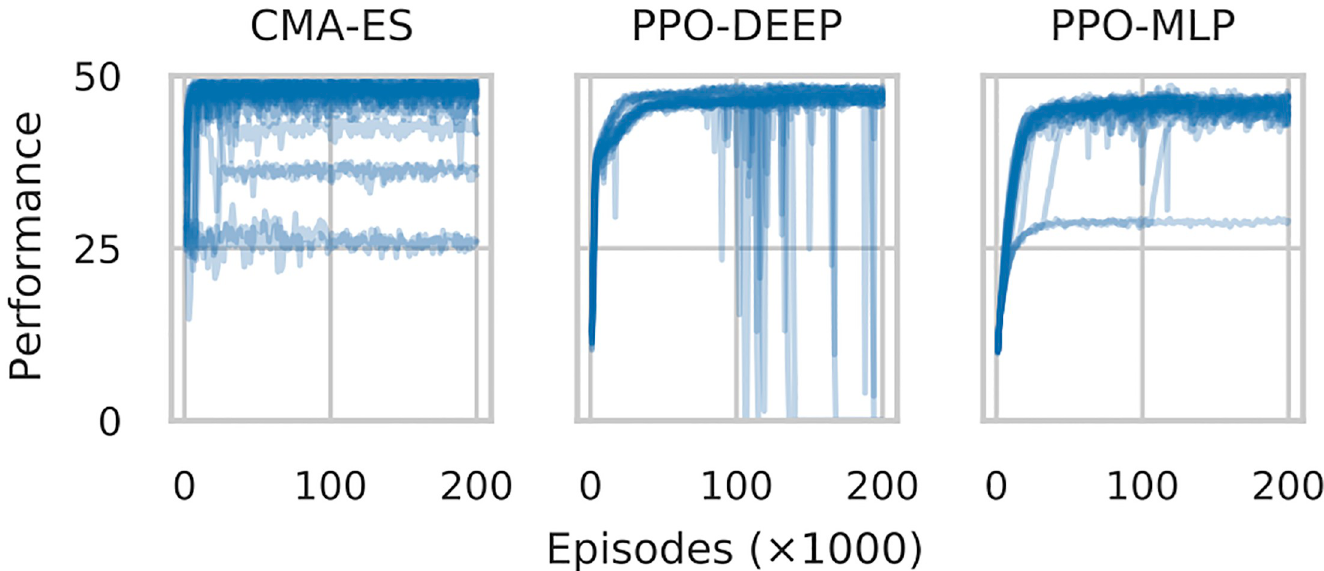
Fig 1. Performance of the best policy throughout learning with CMAES (top), PPO-DEEP (center) and PPO-MLP (bottom), with 24 independent runs per method, for 200 � 10 3 episodes. There are 20/24 runs that produced a policy where performance above 40 with CMAES, 20/24 for PPO-DEEP and 23/24 for PPO-MLP. Note that PPO-DEEP produces 24/24 runs with performance above 40 around episode 80 � 10 3 , with performance occasionally degrading and immediately recovering for some runs afterwards due to the learning step size (see Annex for further analysis).